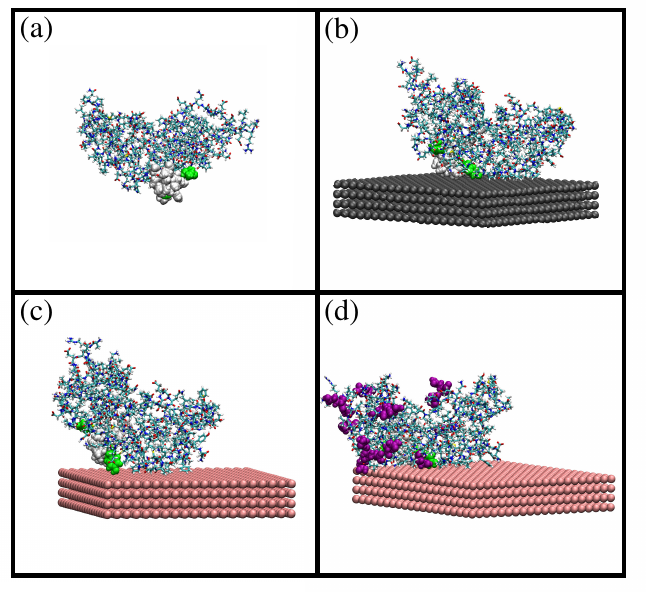
Figure 1. Snapshots from MD simulations of β -casein protein in different situations: ( a ) protein at pH 7 and 298 K; ( b ) protein at pH 7 and 298 K (charge − 8e) adsorbed onto a neutral hydrophobic surface; ( c ) protein at pH 7 and 298 K (charge − 8e) adsorbed onto a negatively-charged hydrophobic surface ( σ = − 0.62 e/nm 2 ); and ( d ) protein at pH 4 and 298 K (charge +6e) adsorbed onto a negatively-charged hydrophobic surface ( σ = − 0.62 e/nm 2 ). The residues 70, 73, 75–82, 85 and 126 (corresponding to the most hydrophobic region of the protein) are shown as van der Waals spheres. In (d), amino acids protonated due to the change in pH are shown as purple van der Waals spheres. These images were made with VMD